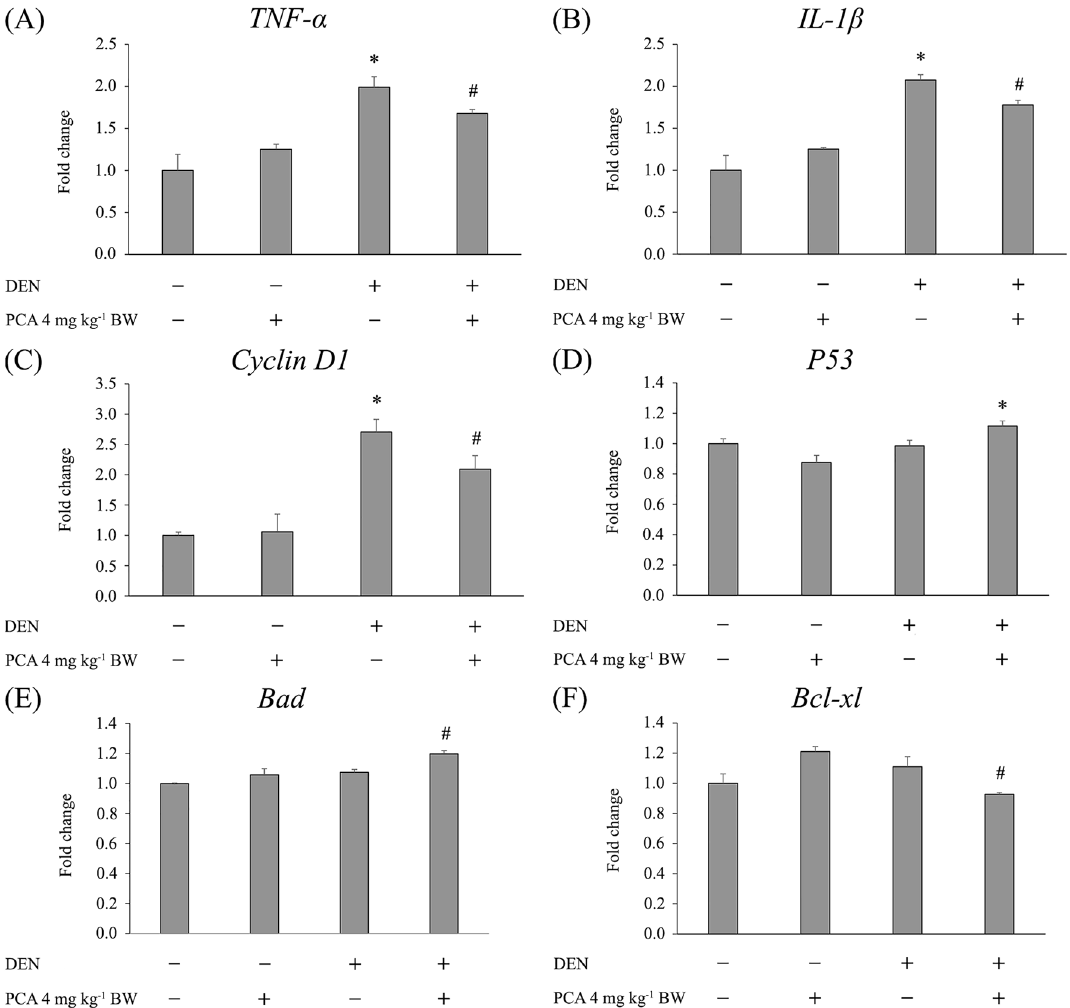
Figure 5. Effect of protocatechuic acid on mRNA levels of genes involved in the initiation and promotion stages of hepatocarcinogenesis (5- and 15-week protocols). Data were normalized to the β-actin mRNA level and are expressed as the fold difference versus the negative control group. ( A ) TNF-α ; ( B ) IL-1β ; ( C ) Cyclin D1 ; ( D ) P53 ; ( E ) Bad ; ( F ) Bcl-xl . Values are expressed as mean ± SEM. *Significantly different from the negative control group, p < 0.05. # Significantly different from the positive control group, p < 0.05. DEN: diethylnitrosamine, PCA: protocatechuic